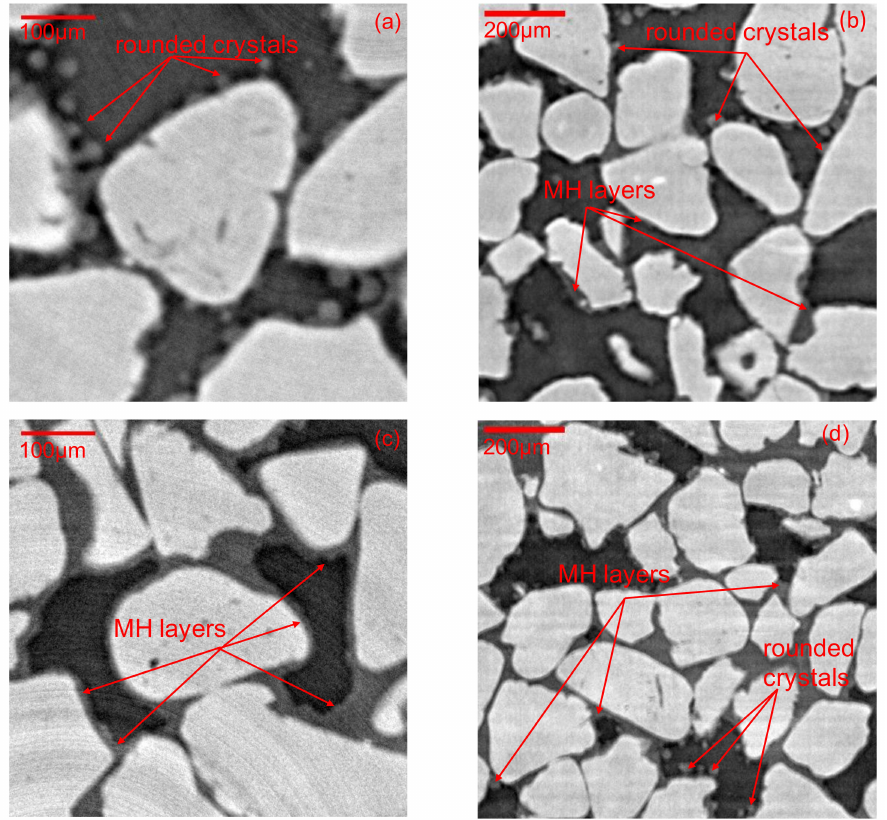
Figure 8. Tomographic sections of the growth of methane hydrate: ( a , b ) after 10 h following the imposition of formation conditions in run 2; ( c , d ) after 6 h in run